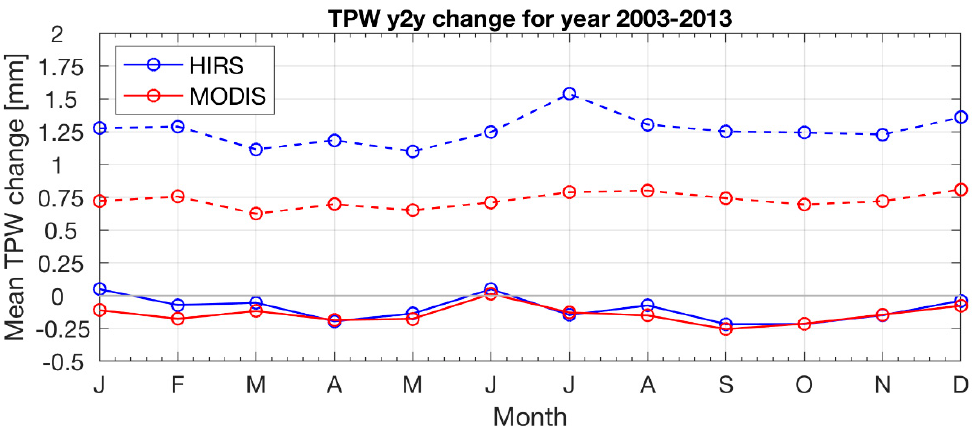
Figure 12. HIRS and MODIS mean (solid) and standard deviation (dashed) of year-to-year TPW changes by month from 60° S to 60° N during 2003 to 2013.